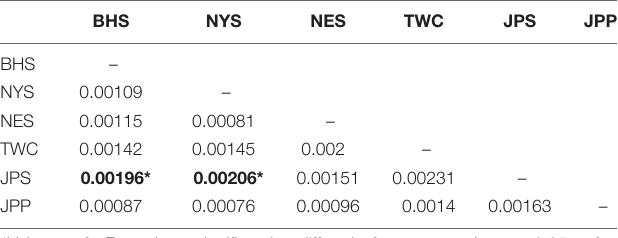
TABLE 3 | Pairwise F ST among 6 geographical regions of E. japonicus based on the dataset of 12,627 SNPs. BHS